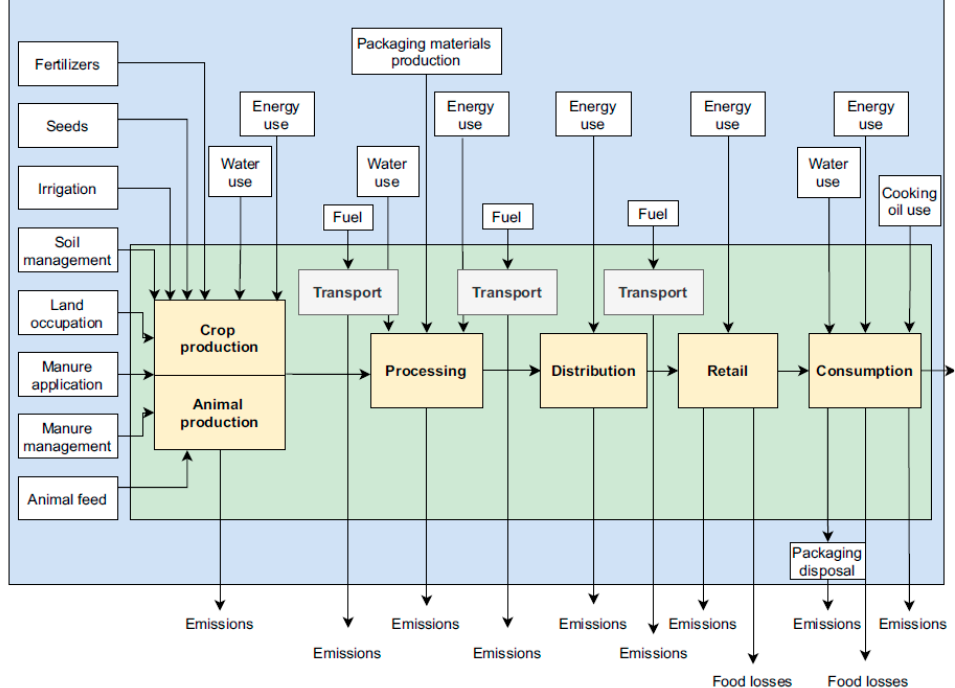
Figure 2. Stages of the life cycle of a product from FF and related sources of environmental and energy impacts. Source: [56]. Reprinted/adapted with permission from [56]. © 2021 The Authors [56].